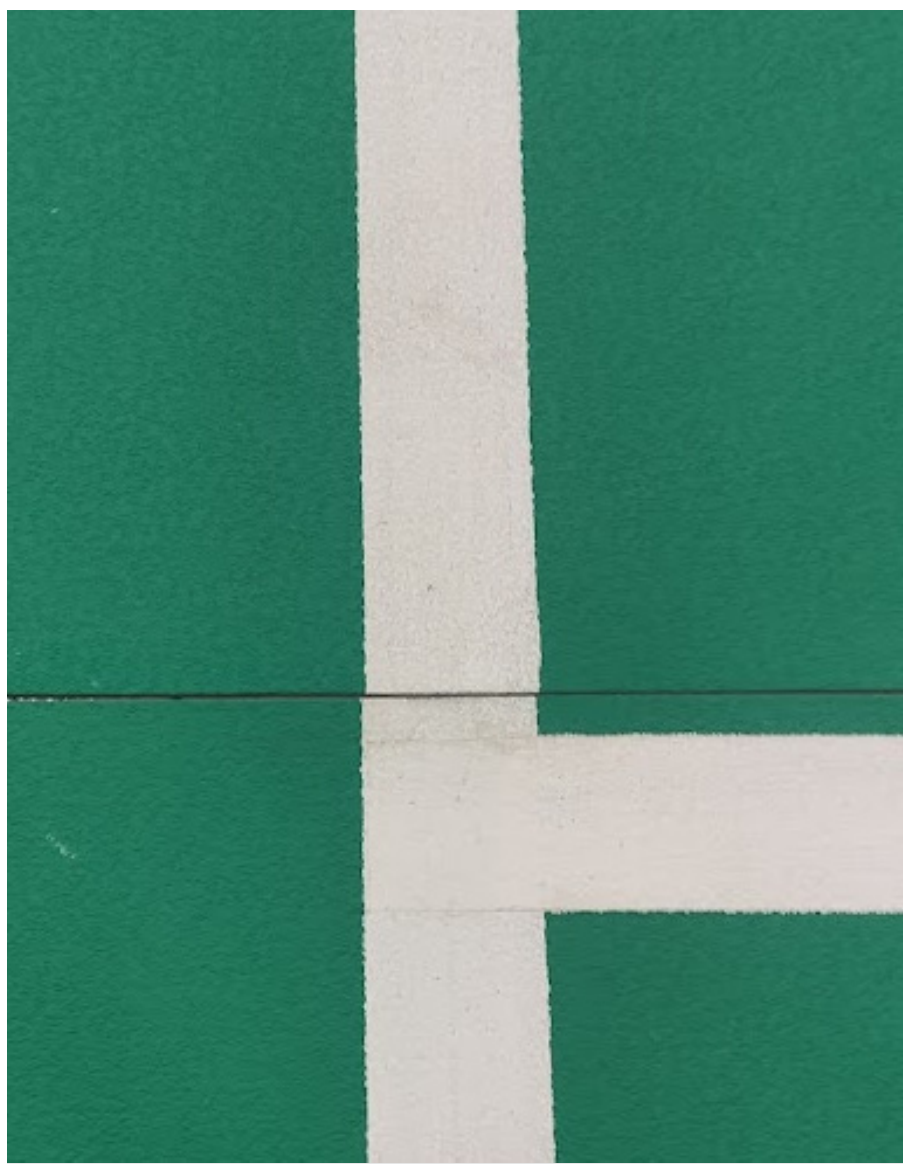
Figure 1. Imprecise mats connection, causing a 2 mm line shift.